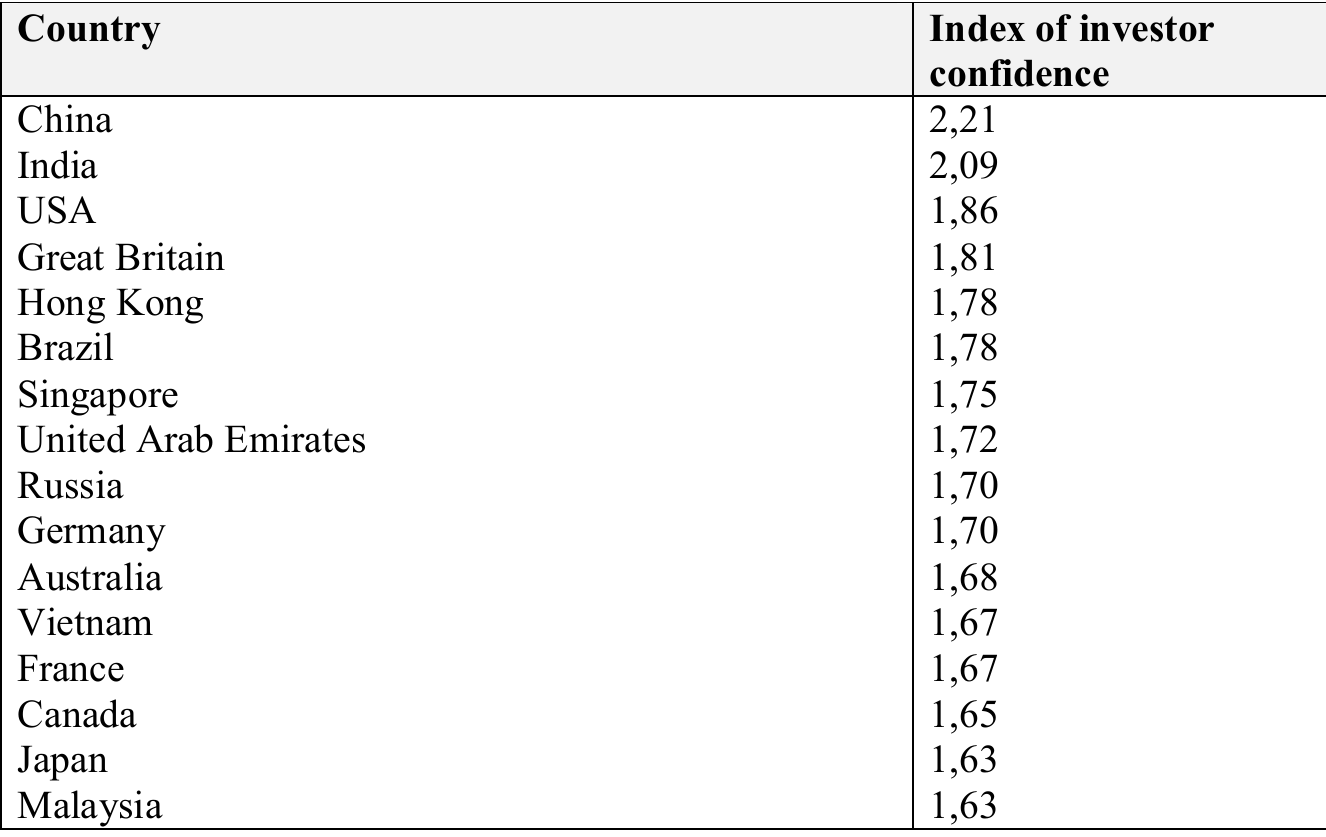
Table 3 - Index of investor confidence (2007) Country Index of